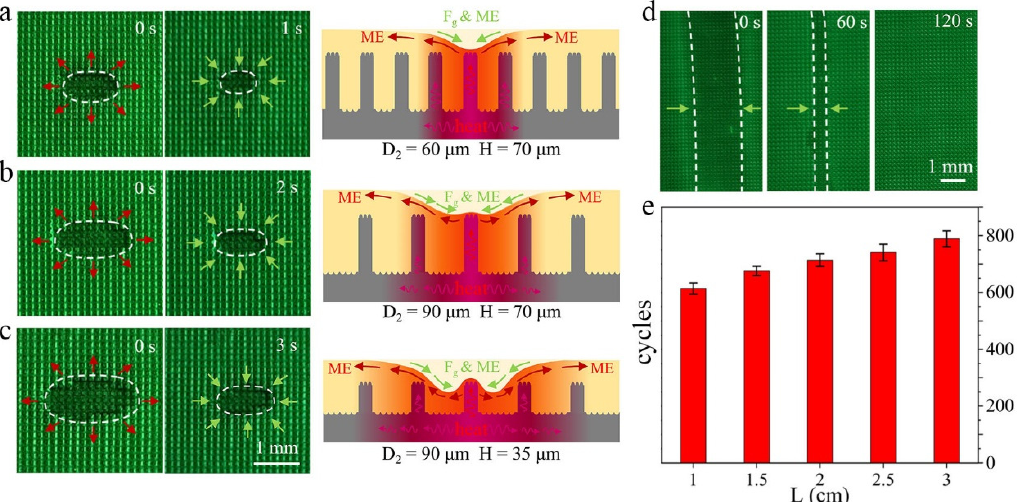
Figure 6. Lubricant layer recovering mechanism and its impact on HD-PTSS performance. ( a – c ) Expelling and recovering of silicone oil layer on PTSS with different morphologic parameters. ( d ) Recovering of silicone oil layer after droplet manipulating invalidation. ( e ) Performance of PTSS with different driving